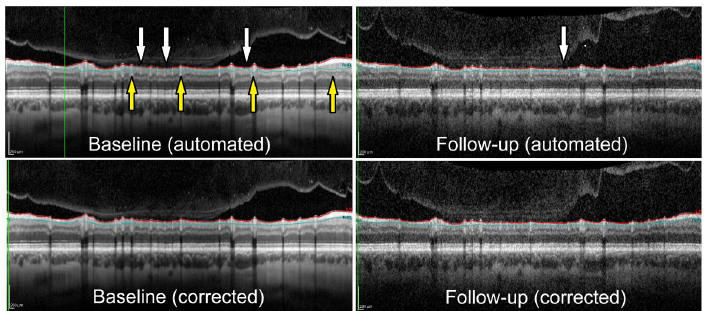
Fig 1. Examples of the extent of manual correction (refinement) of the automated segmentation necessary for adequate delineation of RNFL. White and yellow arrows denote the places where automated segmentation underestimates and overestimates the RNFL thickness,